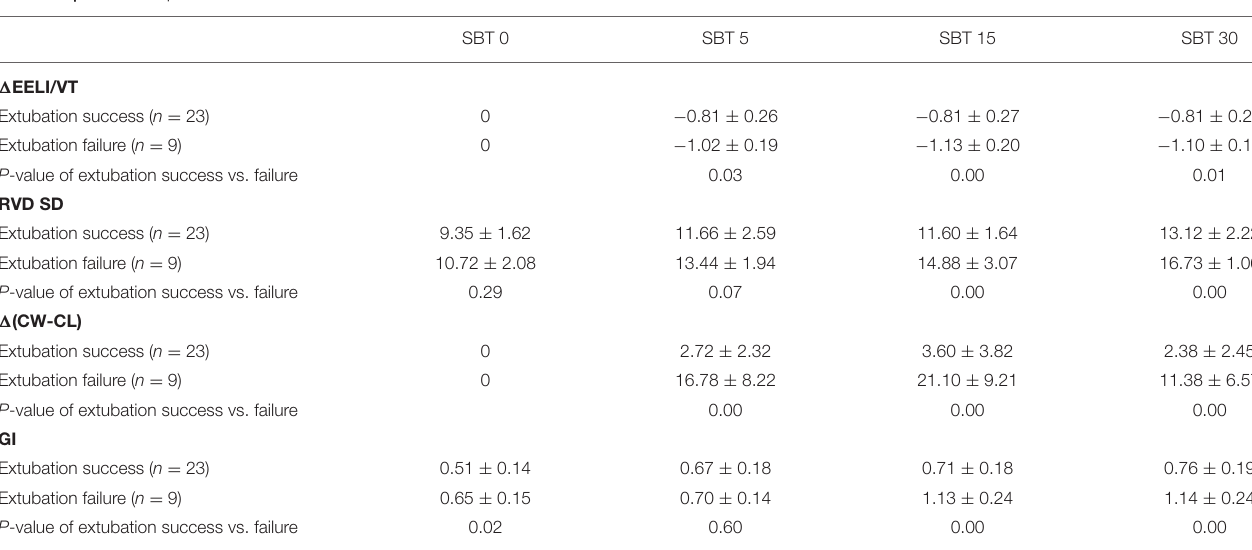
TABLE 3 | EIT data in patients with extubation success and